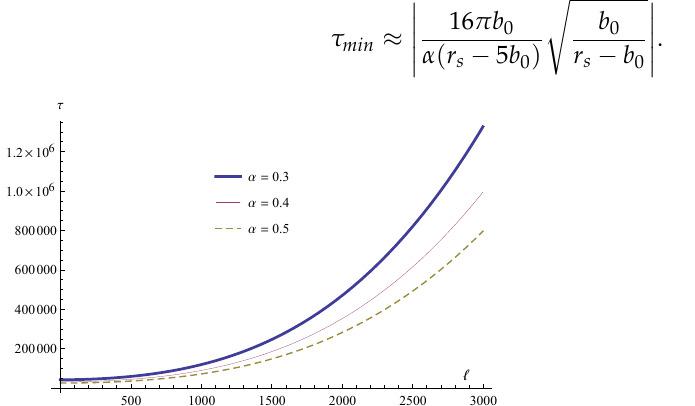
Figure 3. Quantum revival time of the eigenstates of the massless scalar field around the deformed Rindler–Schwarzschild wormhole given in terms of the polar quantum number (cid:96) , for some values of α , with b 0 = 1.0 and r s = 1.000001 b 0 , in Planck